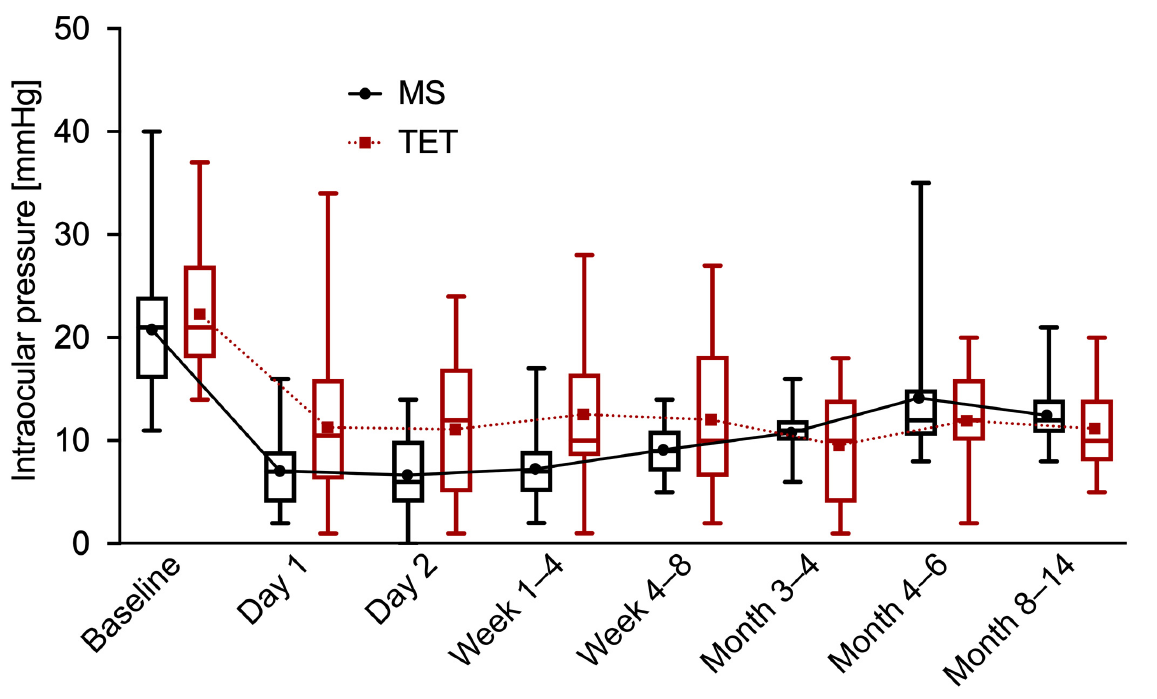
Figure 1. Intraocular pressure. Boxplots of intraocular pressure at each time of follow-up for MicroShunt implantation (MS) and trabeculectomy (TET). The mean values of intraocular pressure are connected by a dotted line.